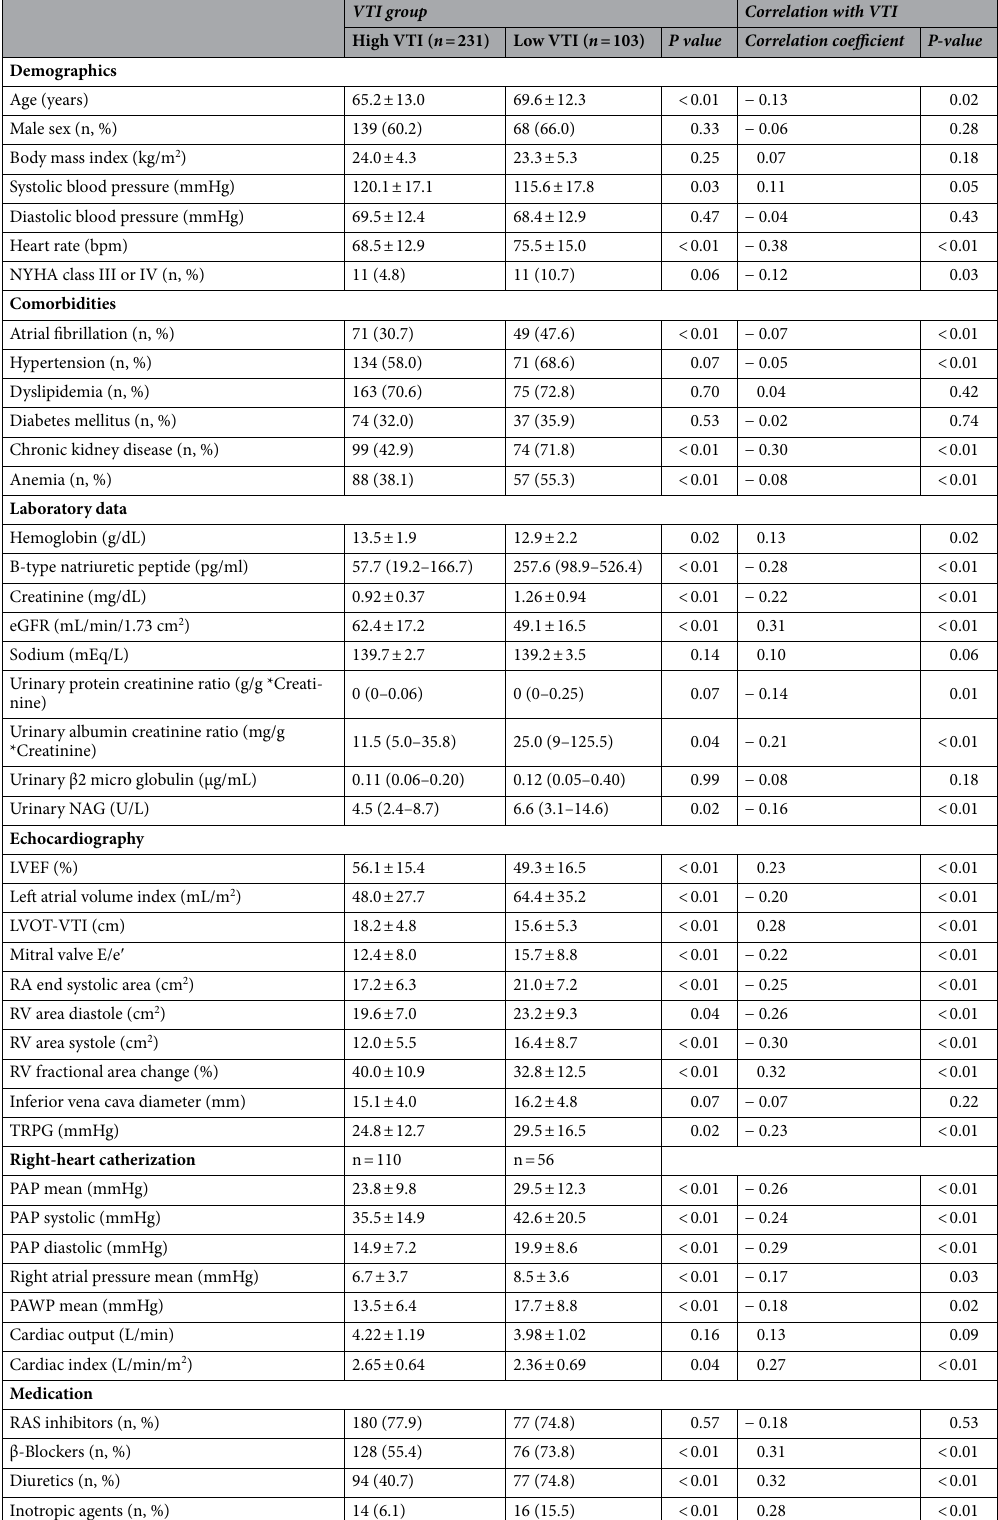
Table 1. Comparisons of patient characteristics between interlobular renal artery VTI groups. VTI velocity time integral, NYHA New York Heart Association, eGFR estimated glomerular filtration rate, NAG N -acetyl- β-d-glucosaminidase, LVEF left ventricular (LV) ejection fraction, LVOT LV outflow tract, RA right atrial, RV right ventriclar, TRPG tricuspid regurgitation pressure gradient, PAP pulmonary artery pressure, PAWP pulmonary artery wedge pressure, RAS renin-angiotensin